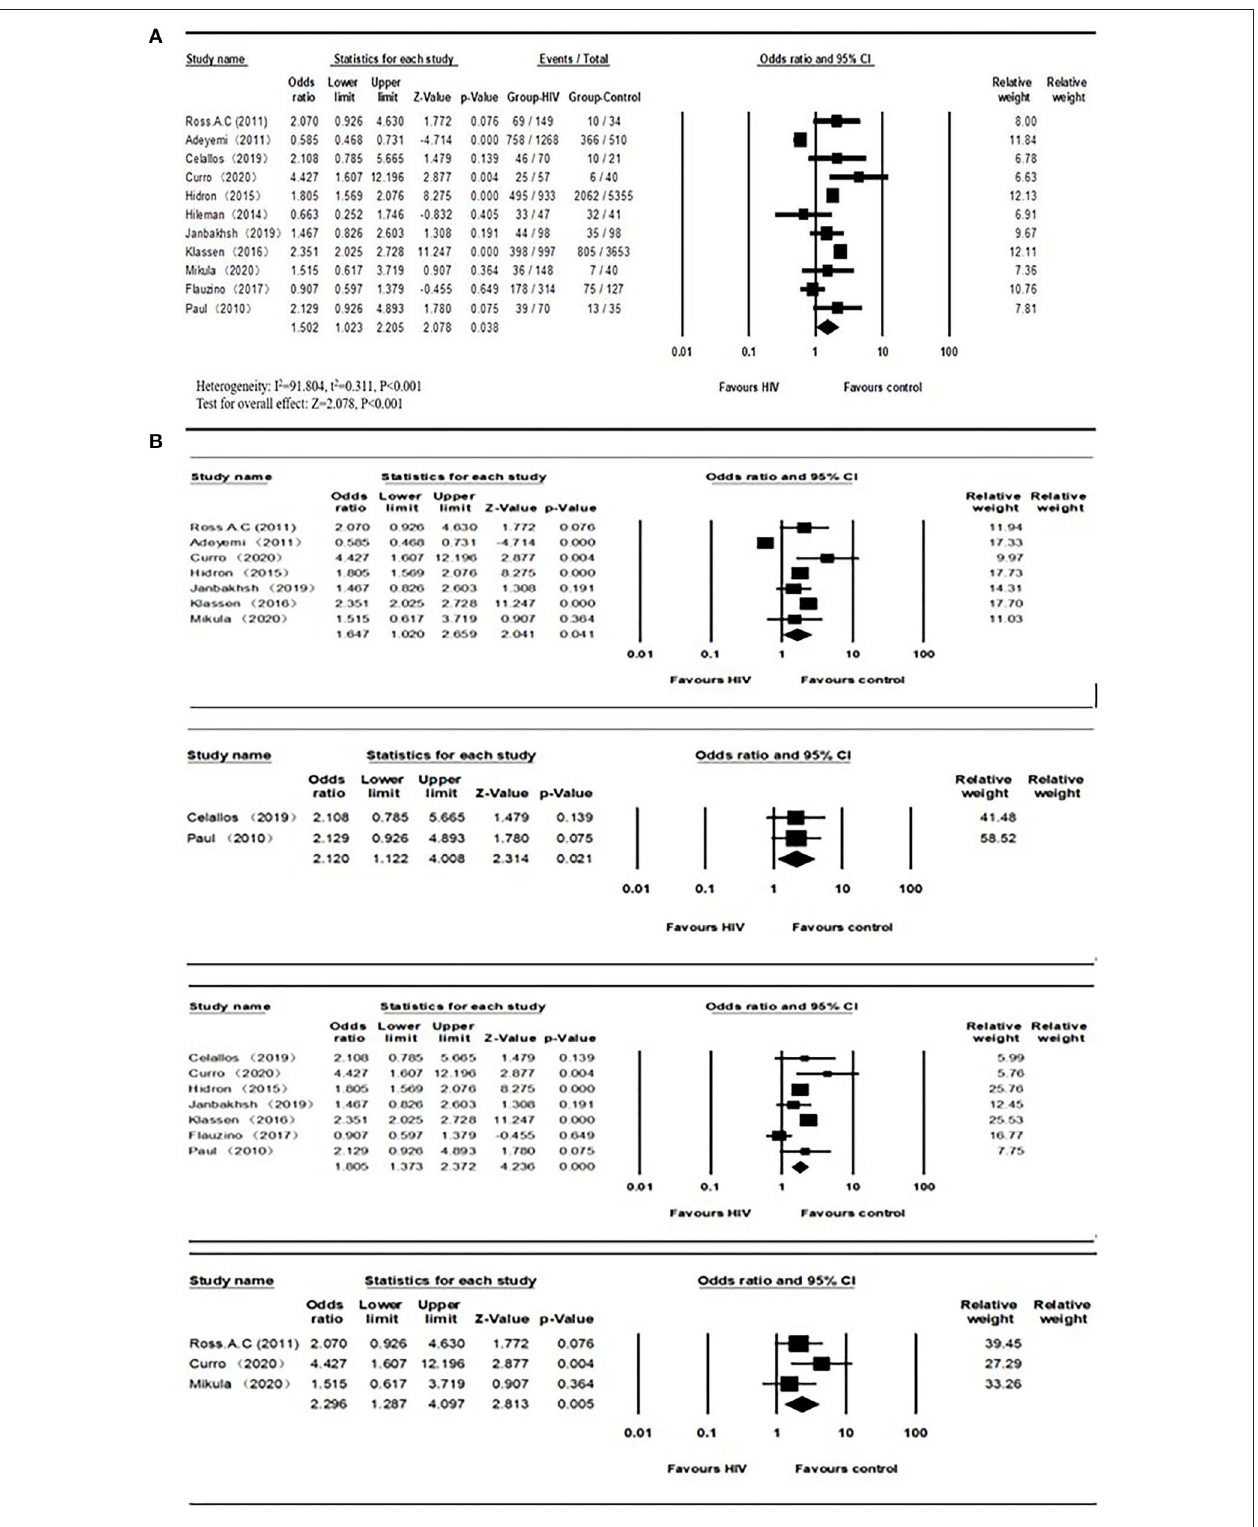
FIGURE 2 | (A) Vitamin D deficiency prevalence in HIV and control groups; (B) Subgroups of vitamin D deficiency (Age > 40, BMI ART-experienced studies from top to bottom) prevalence between HIV and control groups.